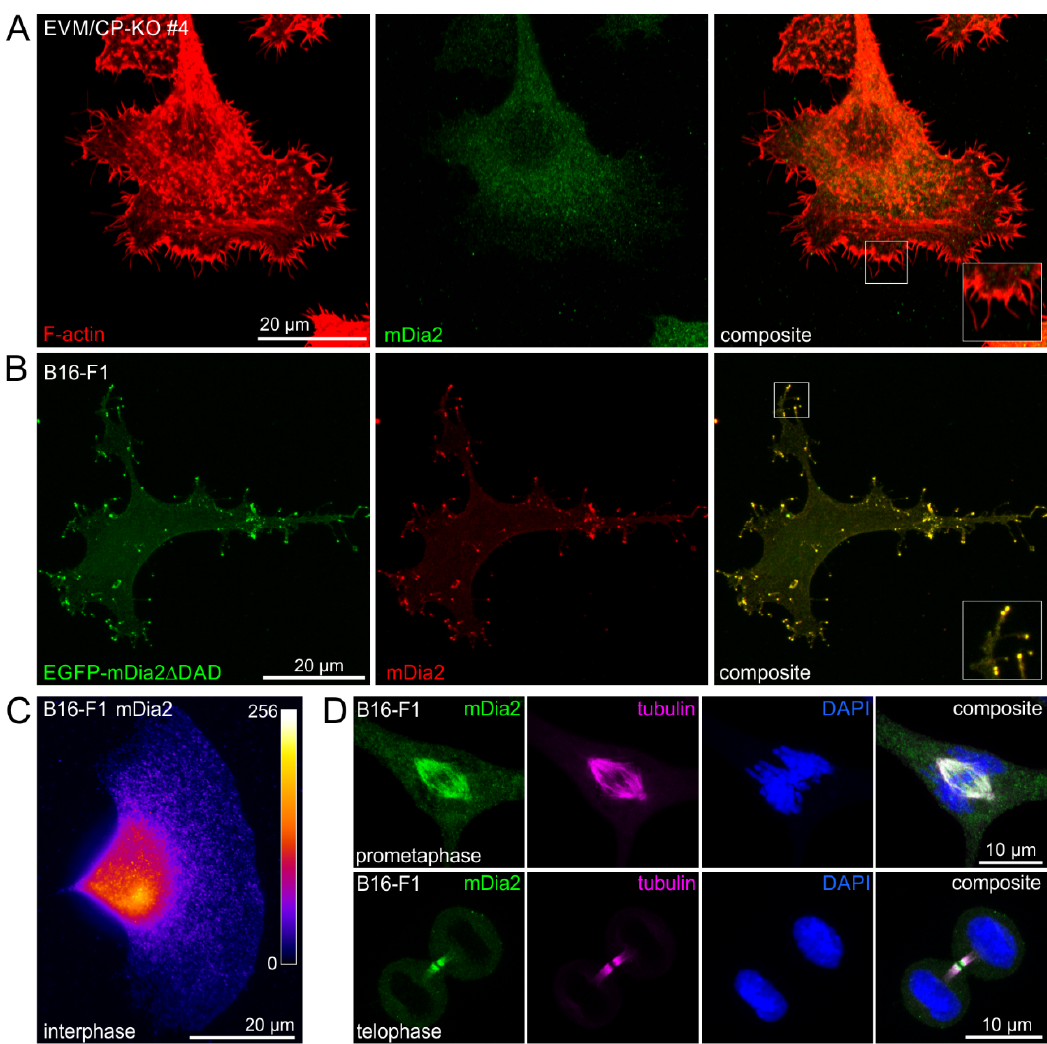
Figure 6. Endogenous mDia2 is not detectable at the tips of filopodia and lamellipodia but accumulates prominently together with tubulin at the mitotic spindle and midbody of dividing B16-F1 cells. ( A ) Representative image of an EVM/CP-KO cell stained for endogenous mDia2 and F-actin. Note the lack of mDia2 enrichment at filopodia tips. Inset, enlarged image of boxed region. Scale bar, 20 µm. ( B ) Ectopically expressed EGFP-mDia2∆DAD triggers filopodia formation in B61-F1 cells, with active mDia2 localizing to the distal tips of filopodia. Remarkably, even at low expression levels, ectopically expressed EGFP-mDia2∆DAD was effectively recognized by the anti-mDia2 antibody. Inset, enlarged image of boxed region. ( C ) Heat map of endogenous mDia2 signal intensity in a representative B16-F1 cell during interphase, forming a prominent lamellipodium. Note the lack of mDia2 enrichment at the lamellipodium tip. ( D ) Representative images of B16-F1 cells stained for endogenous mDia2, tubulin and DNA with DAPI in prometaphase (upper panel) and telophase (lower panel).